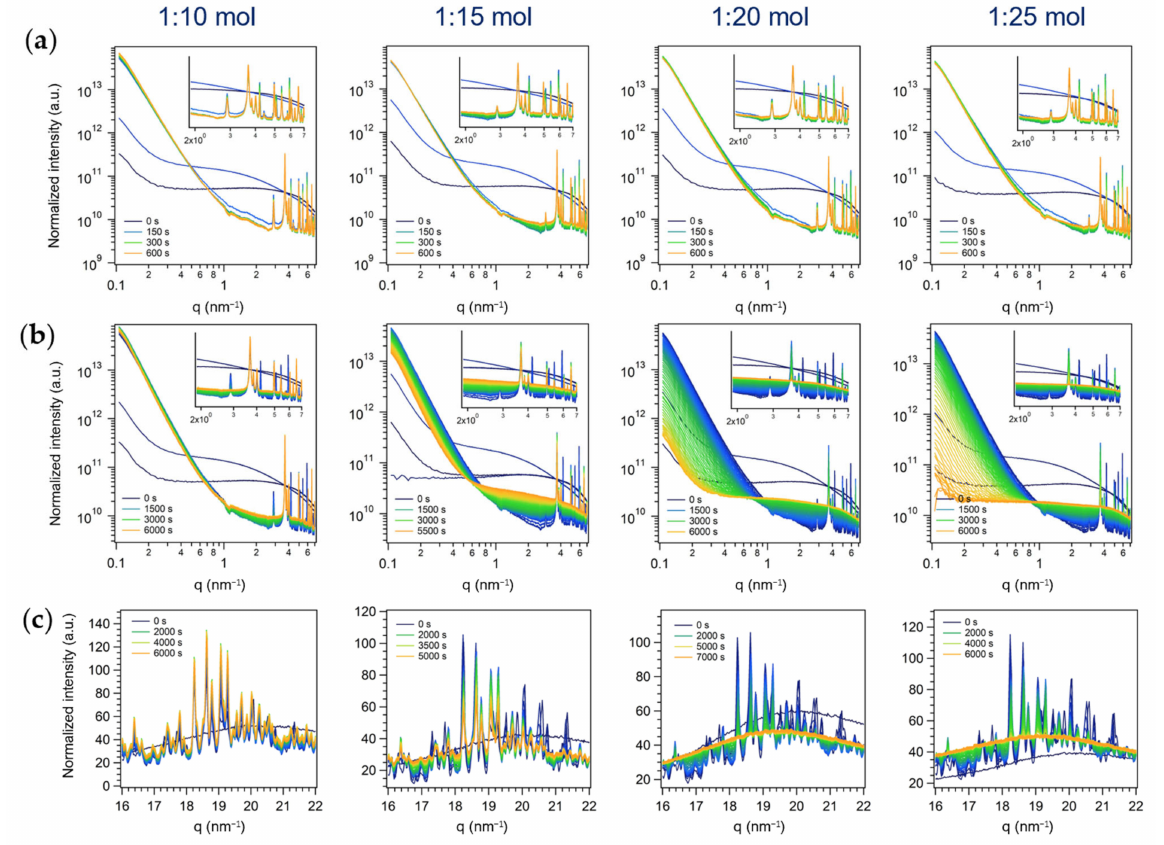
Figure 9. In situ time-resolved ( a , b ) log-log plots of SAXS and ( c ) simultaneous WAXS patterns of the series of experiments performed in batch with different AHM:HNO 3 molar ratios (third series of experiments). A SAXS pattern ( a ) every 50 s from the start of acid addition (t = 0 s) to 600 s and ( b ) every 100 s from the start of acid addition (t = 0 s) to 5500–6000 s. Insets: zoom on Bragg peaks (1.9–7 nm − 1 ). ( c ) A WAXS pattern every 100 s from the start of acid addition (t = 0 s) to the end of